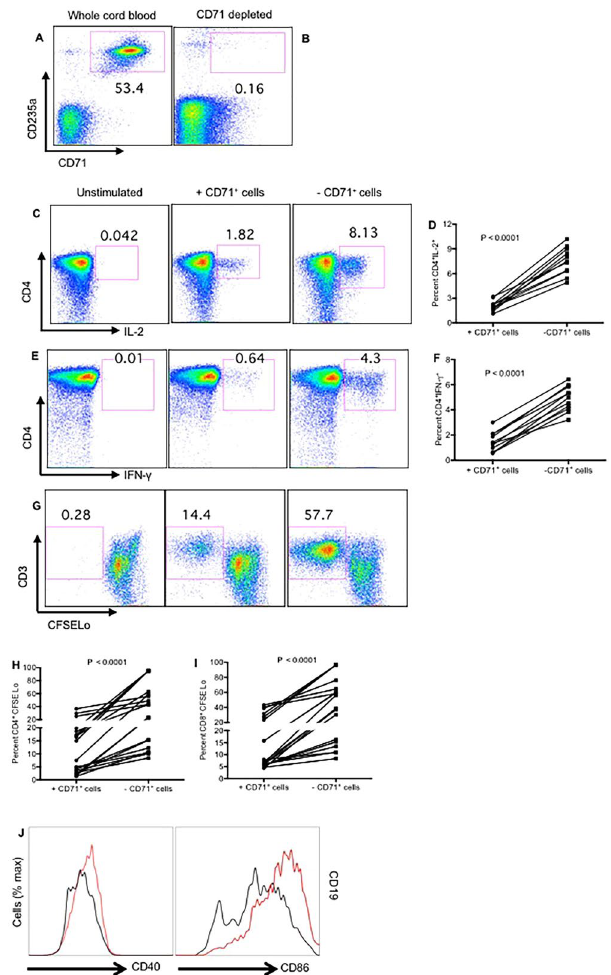
Figure 7. Impaired functionality of T cells and B cells by cord blood CD71 + cells. ( A ) Representative plots showing presence of CD71 + CD235a + cells in cord blood. ( B ) Representative plots showing depletion of these cells by cell separation techniques. ( C ) Representative plots showing IL-2 production by cord blood CD4 + T cells in the presence and absence of CD71 + cells. ( D ) Percent IL-2 producing CD4 + T cells from 12 individual unfractionated and CD71 + cell depleted cord blood specimens. ( E ) Representative plots showing IFN- γ production by cord blood CD4 + T cells in the presence and absence of CD71 + cells. ( F ) Percent IFN- γ producing CD4 + T cells from 12 individual unfractionated and CD71 + cell depleted cord blood specimens. ( G ) Representative dot plots showing percentages of CFSELo CD3 + in the presence and absence of CD71 + cells. ( H , I ) Percent proliferation of CD4 + T cells or CD8 + T cells respectively measured by CFSE dilution assay in the presence and absence of CD71 + Cells, data are from 20 cords blood specimens. Each point represents data from an individual human subject (cord blood), obtained from multiple independent experiments. ( J ) Relative CD40 and CD86 expression by cord blood CD19 cells (red histograms gated on CD19 + cells in the absence of CD71 + cells) or (black histograms gated on CD19 + cells in the presence of CD71 +